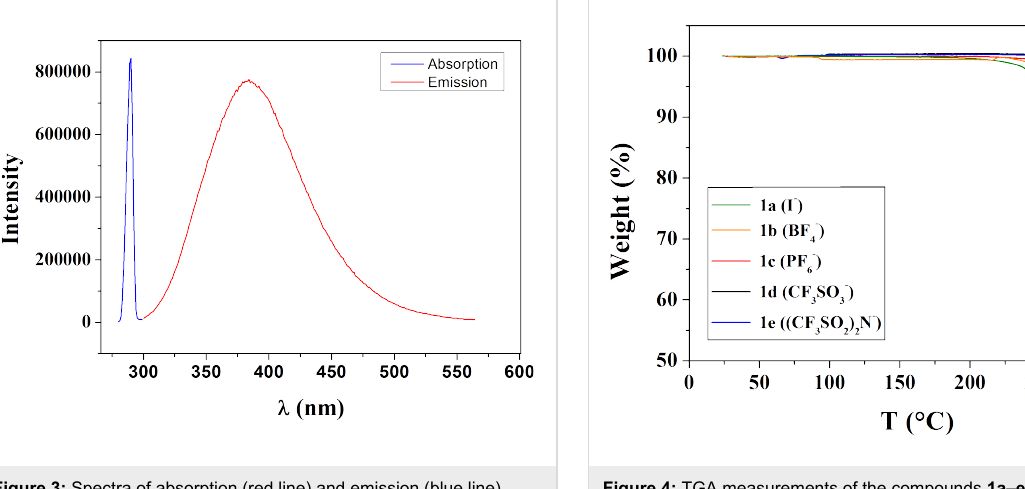
Figure 4: TGA measurements of the compounds 1a–e (rate 10 °C·min −1 , in